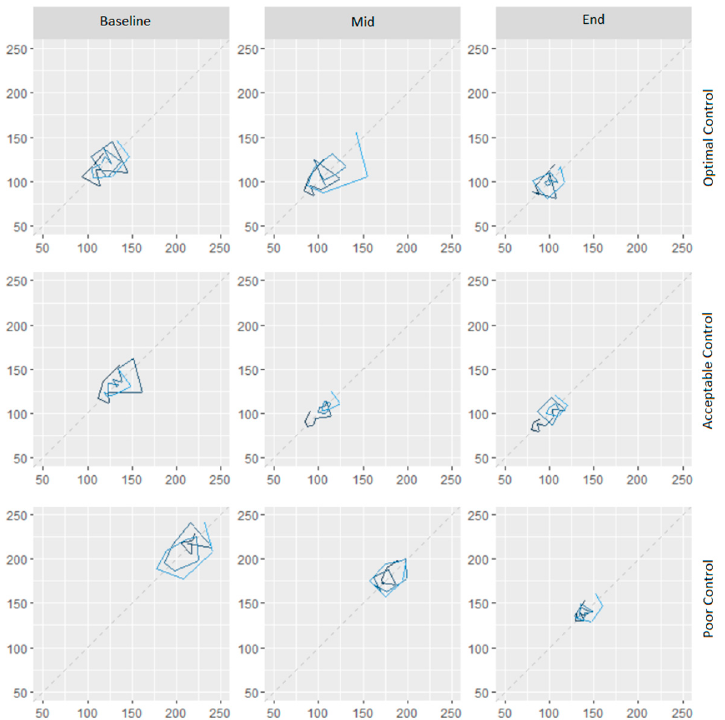
Figure 2. Composite assessment of glycemic control and variability based on raw glucose values at the same time on two sequential days (lag plot).